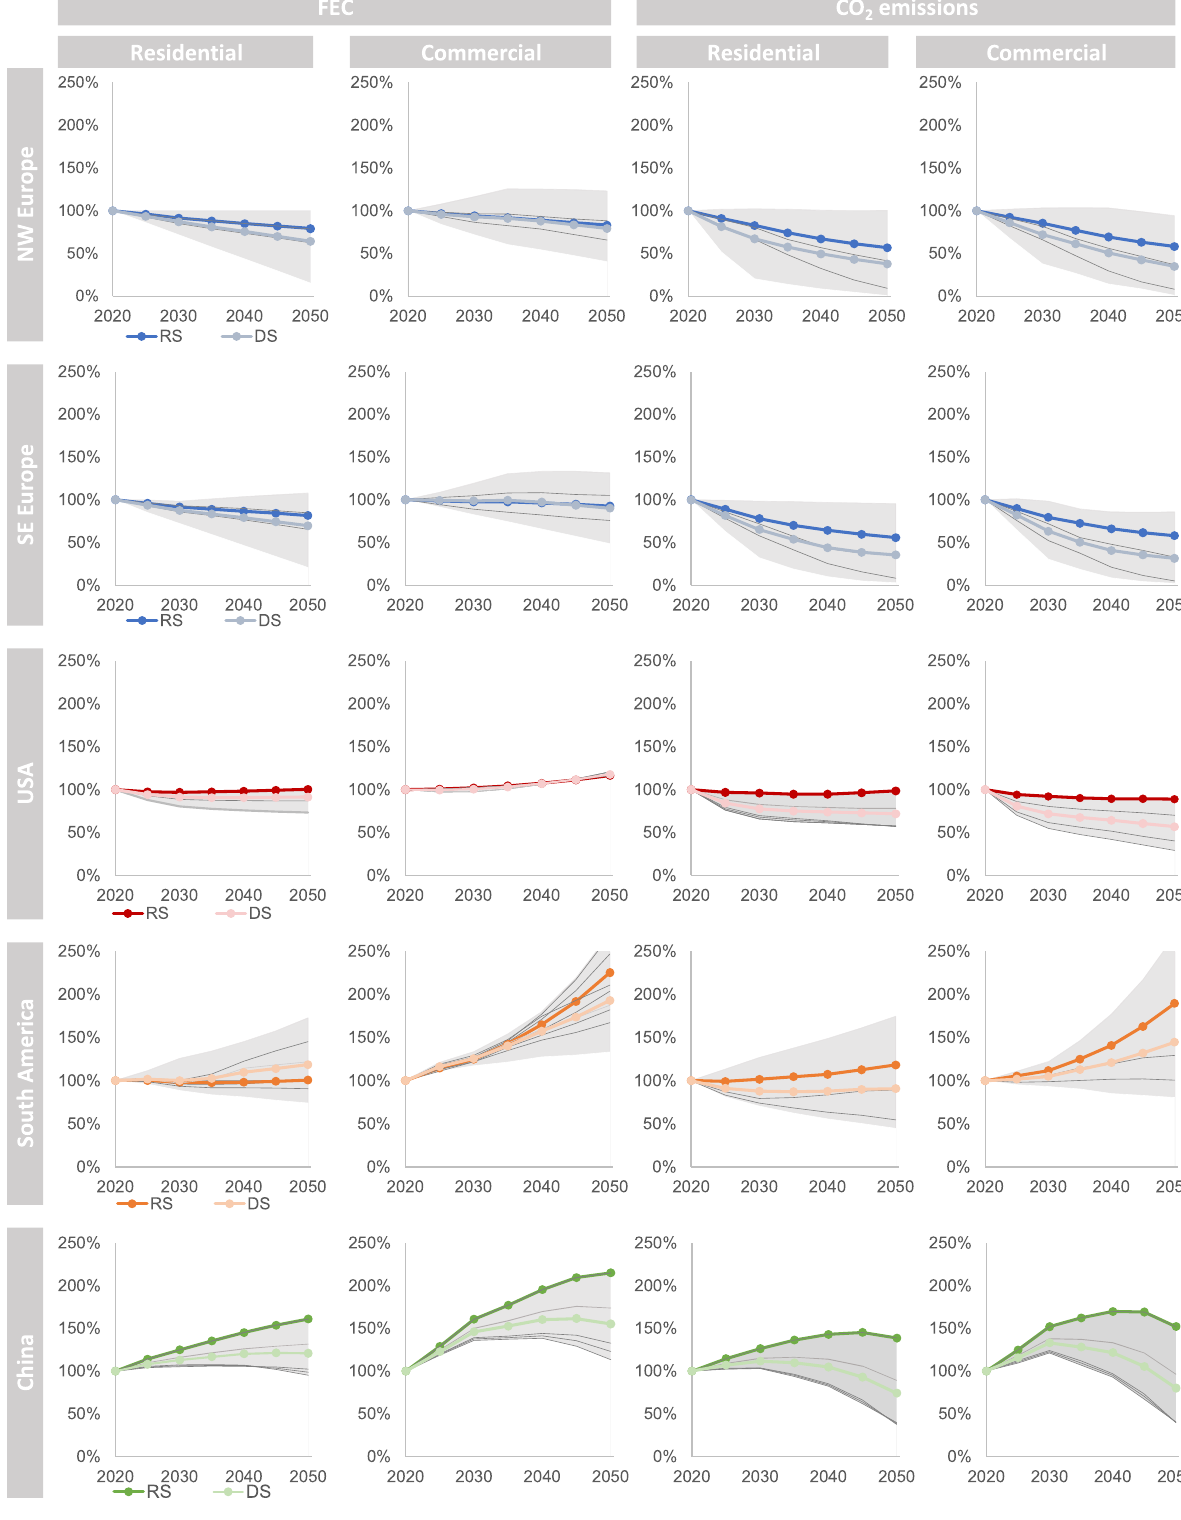
NATURE COMMUNICATIONS| (2022) 13:3077